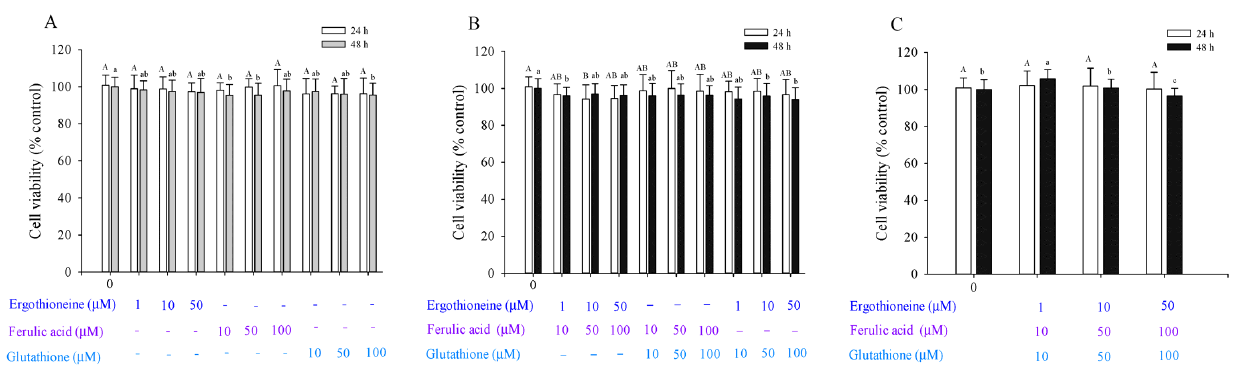
Figure 1. Schematic illustration of three types of antioxidants in the prevention of UVB radiation-induced photoaging in human skin fibroblasts.